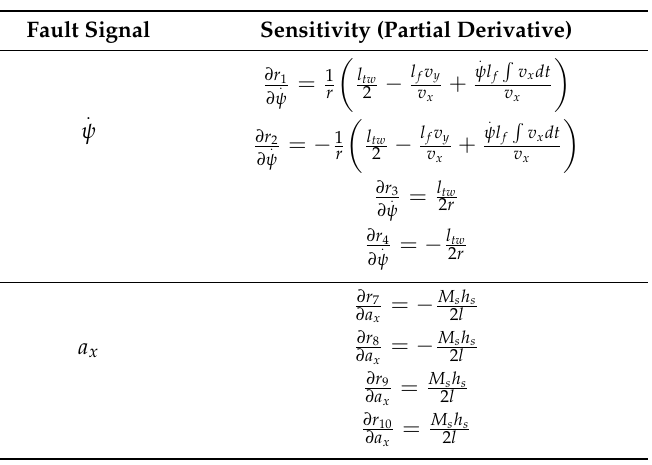
Table 6. The sensitivity of residuals with a fault